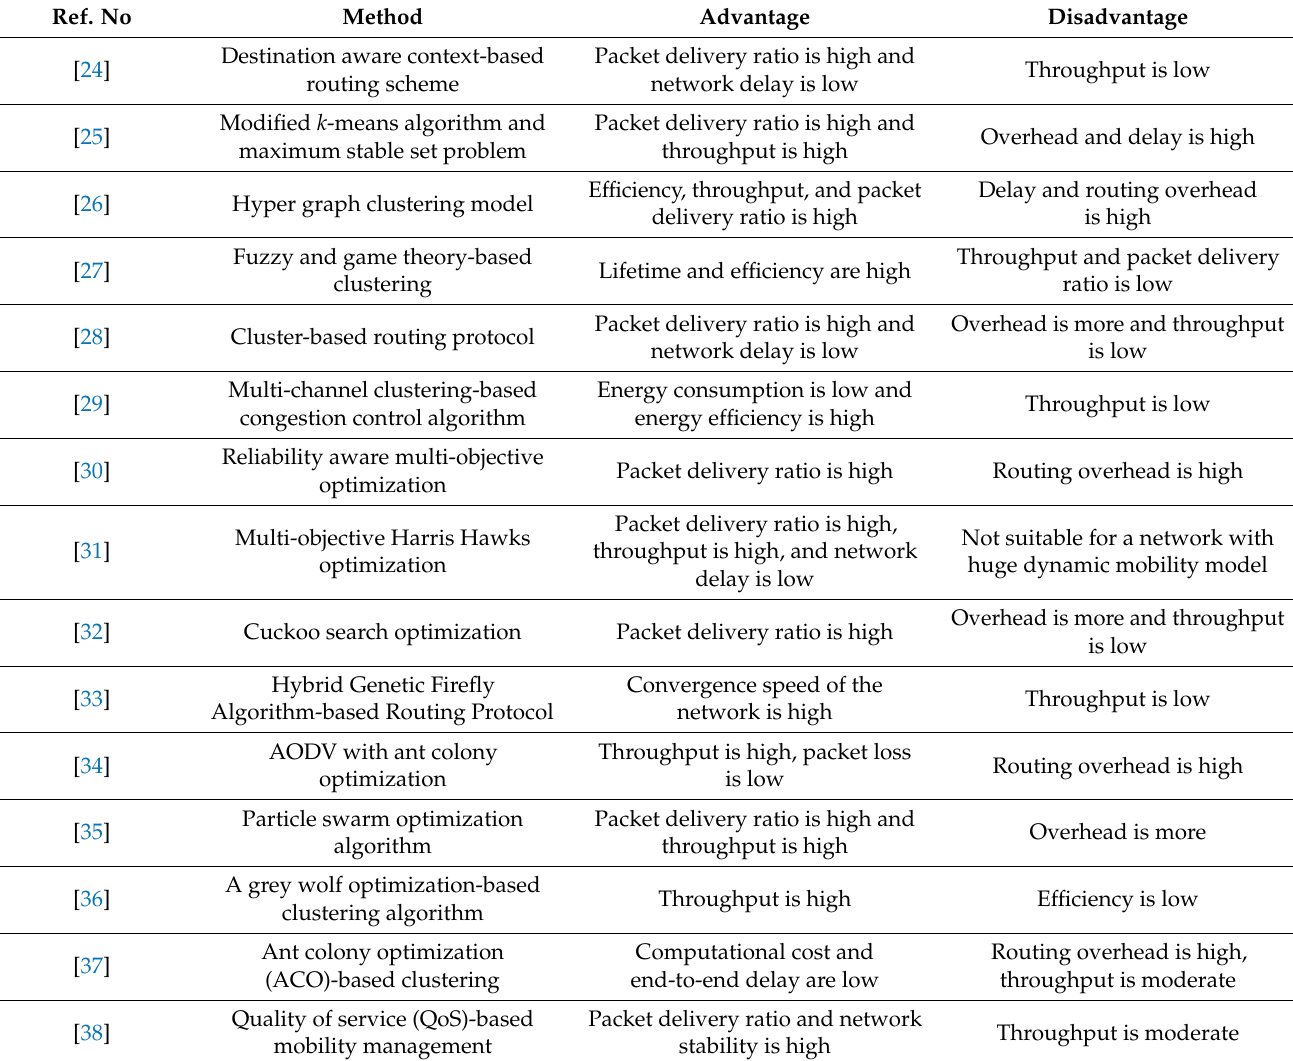
Table 1. Summary of the